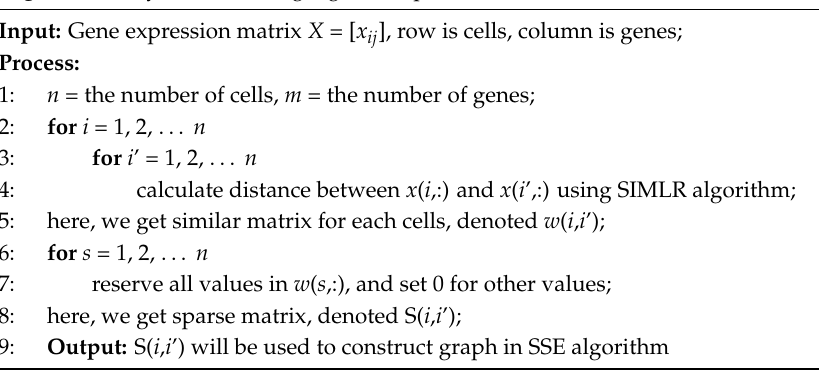
Algorithm 1 Hybrid clustering algorithm